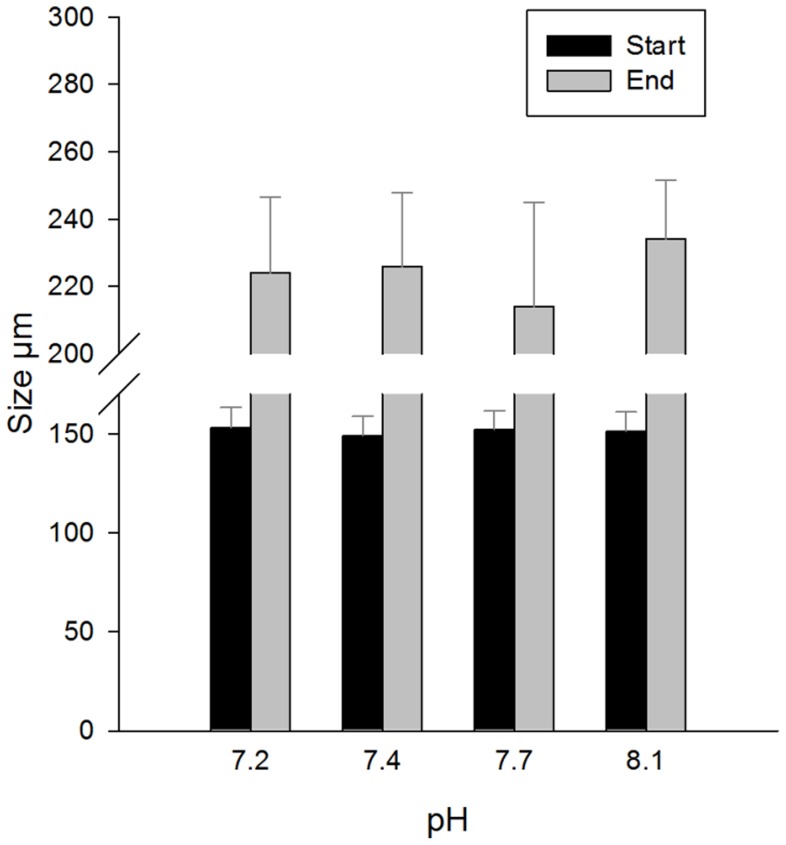
Larval sizes at the start and end of the experiment in different pH treatments.Mean ±SD, n = 105.